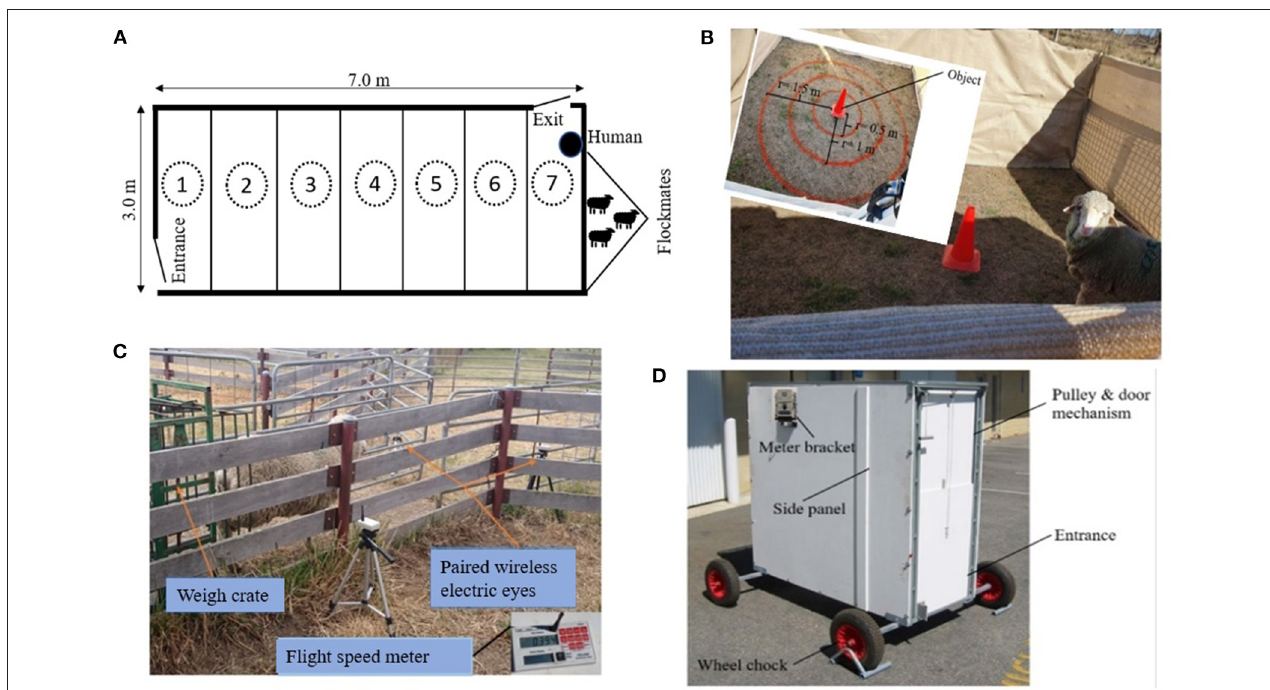
FIGURE 1 | A schematic of the behavioral tests including: (A) arena test, (B) novel object test, (C) flight speed test, and (D) isolation box test.